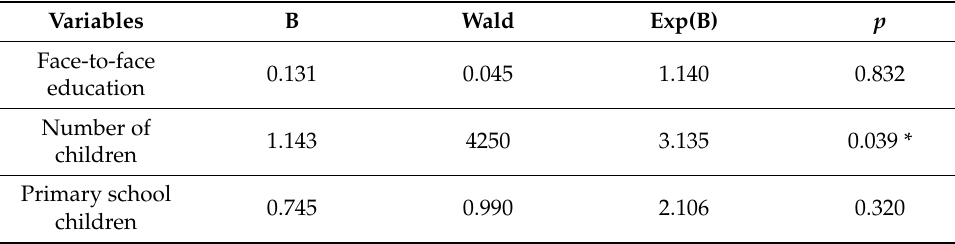
Table 4. Parameters affecting presence of clinically significant parenting stress.